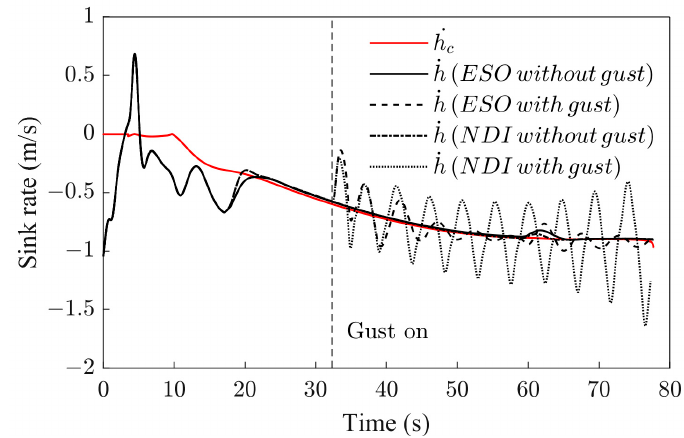
Figure 24. Sink rate control under the wind gust.